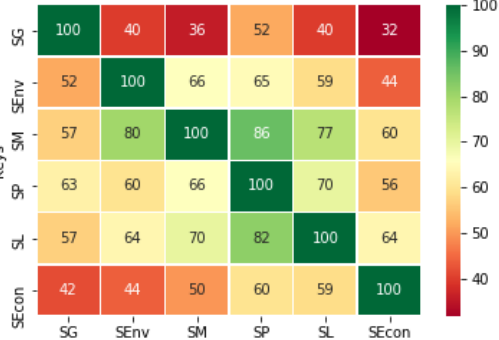
Figure 6. Statistical heatmap depicting the relationships between SCIs pertaining to the case studies.